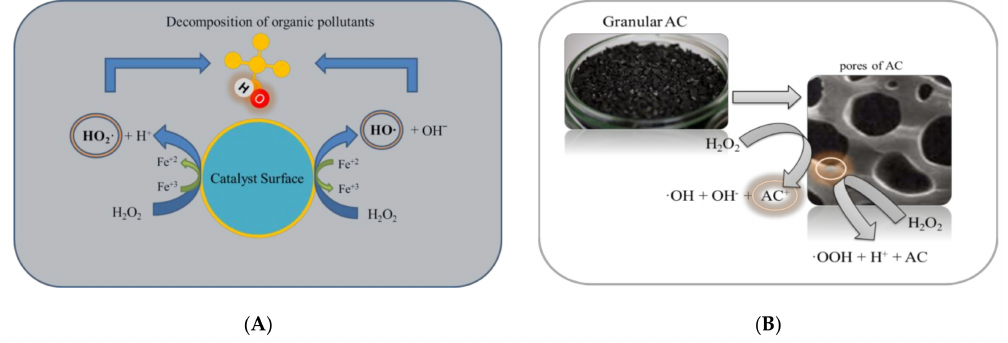
Figure 4. Schematic representation of CWPO mechanism A —catalysed by iron-based materials; B —catalysed by carbon materials (in the absence of